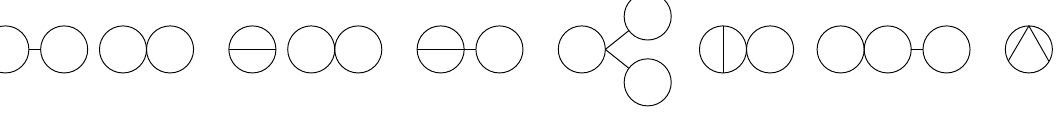
Figure 8 . Diagrams appearing in the Wick contraction of ϕ (Ω) 3 ϕ (Ω 0 ) 3 ϕ (Ω 00 ) 4